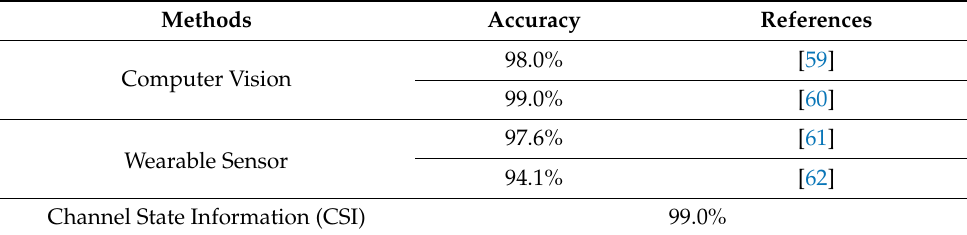
Table 2. Fall detection accuracy of fall detection systems using different